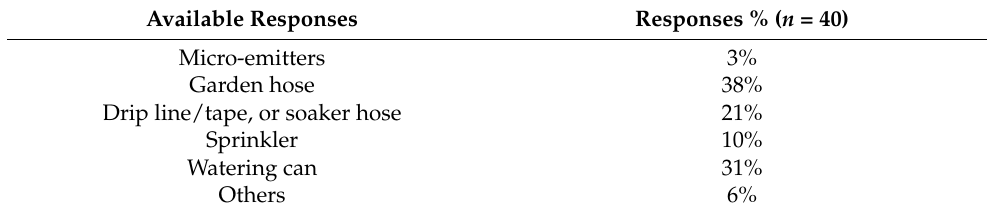
Table 3. Survey participants’ responses to the question, “How do you supply irrigation water to your farm?”. Available